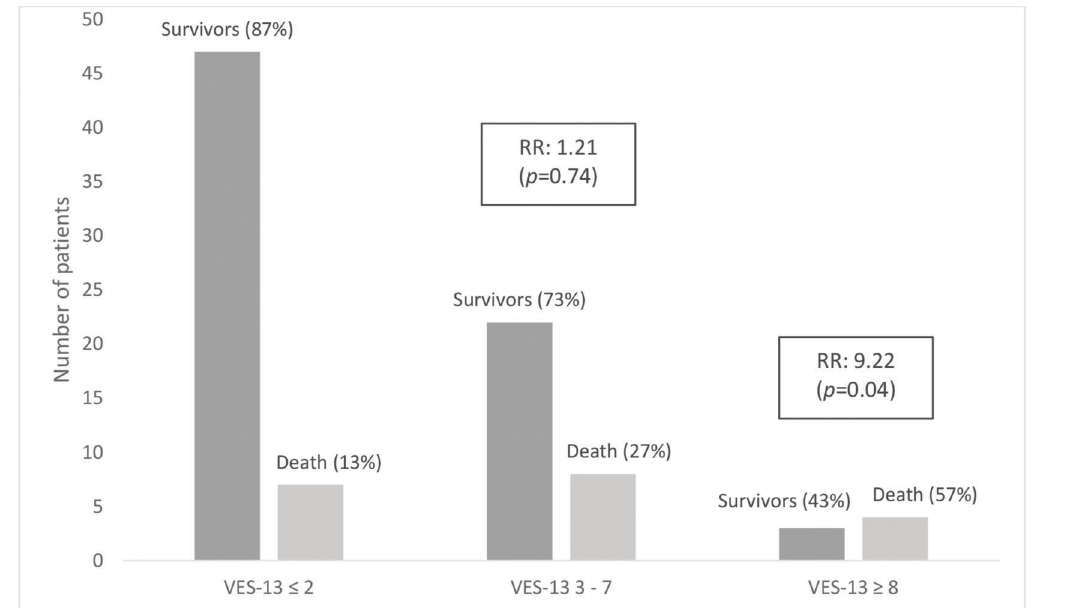
Figure 1 - Association between VES-13 and mortality. VES-13 = Vulnerable Elders Survey, RR = Relative risk.